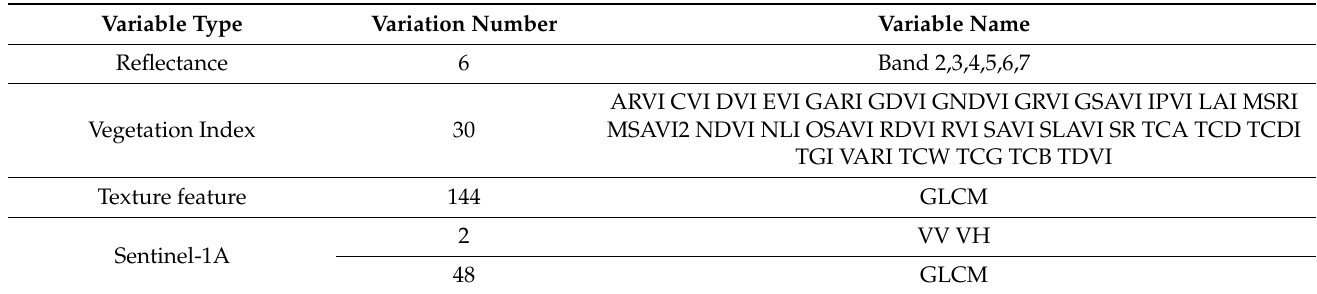
Table 3. Feature